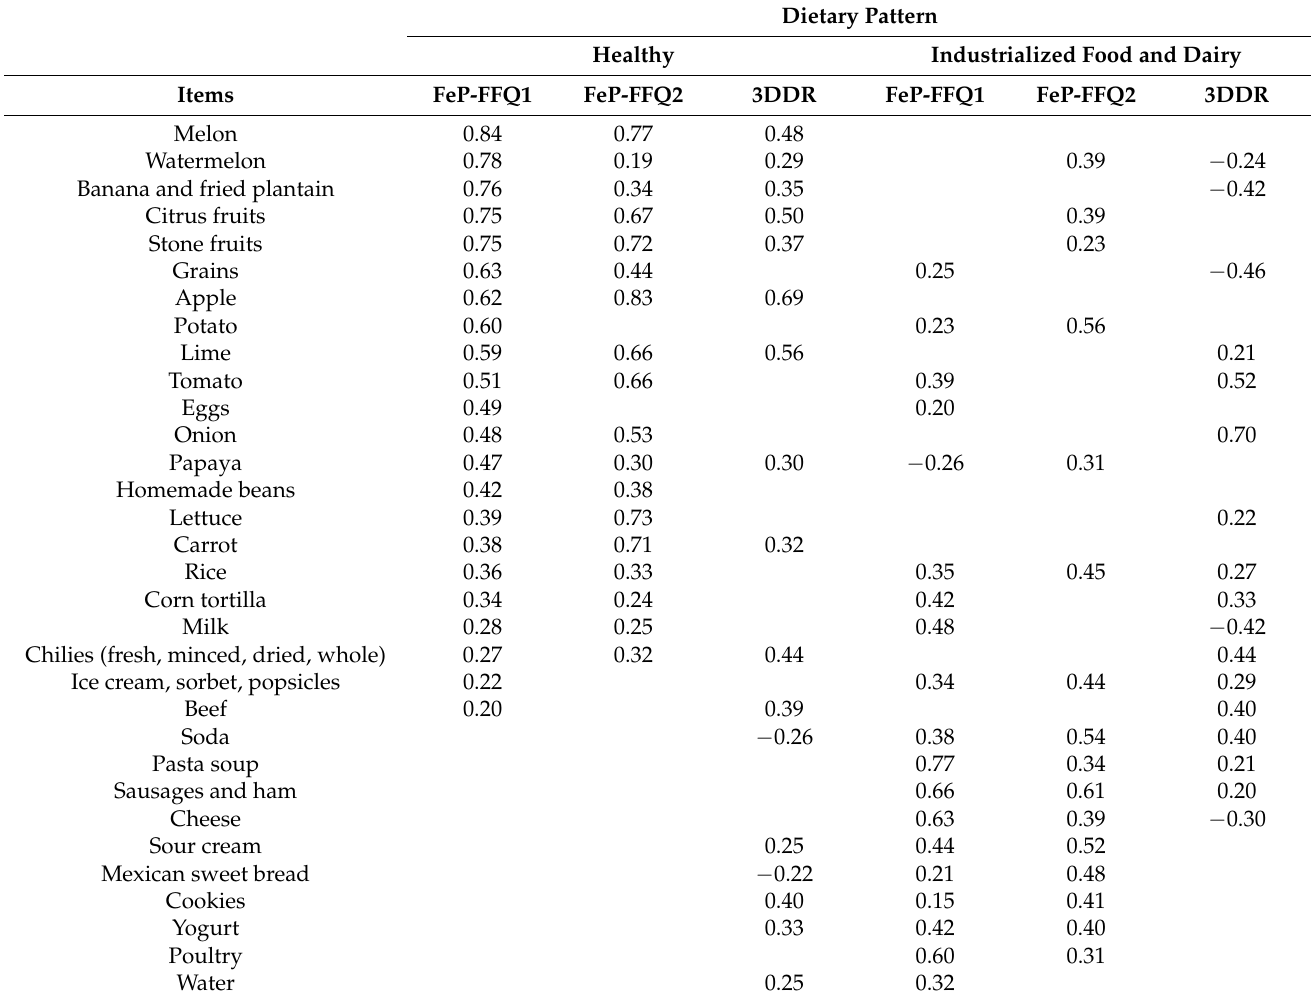
Table 3. Factor loadings for the two identified dietary patterns by administration of FeP-FFQ1, FeP-FFQ2, and 3DDR ( n = 110). Dietary